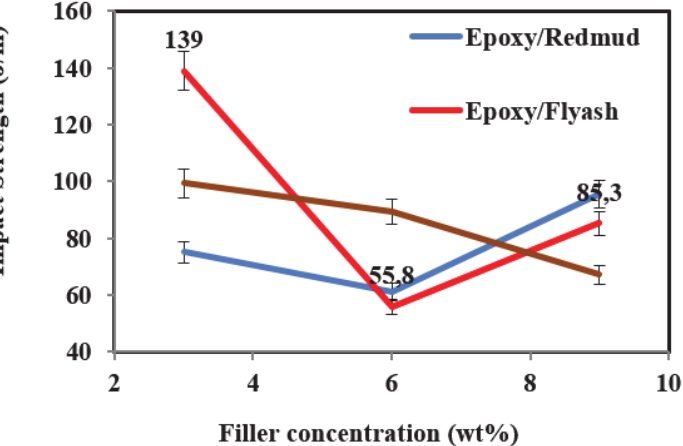
Figure 4: Impact strength of composites at different filler